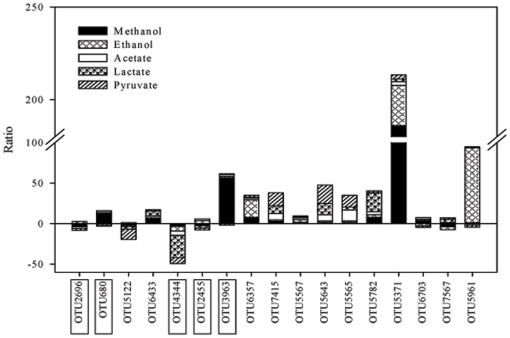
Commonly existing OTUs among the treatments with different electron donor amendments.Ratios were the quotient of the high relative abundance dividing the low relative abundance from treatment or control. Positive ratio means the relative abundance increased in the treatments with electron donors, while the negative ratio means decrease. The labels with rectangle were present in the initial inocula.